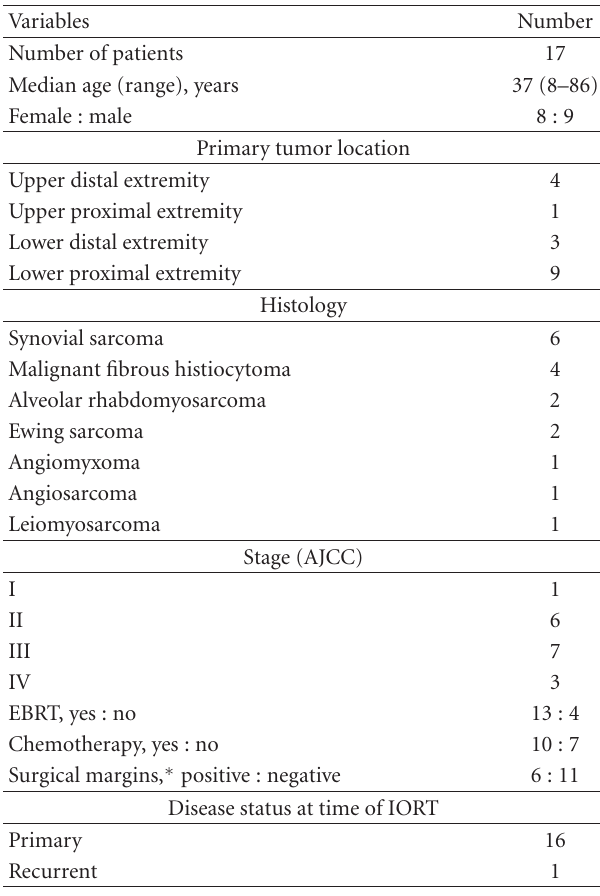
Table 1: Patient characteristics and treatment